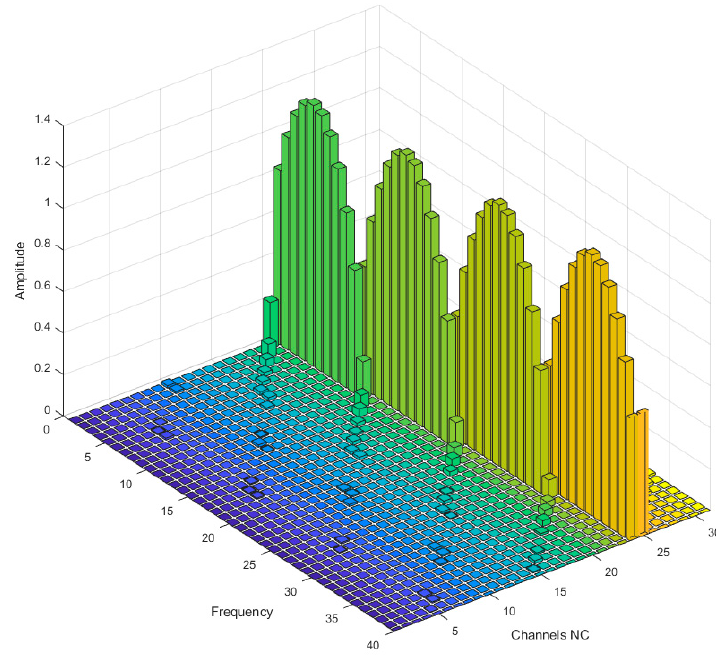
Figure 7. Frequency response of NC channels.